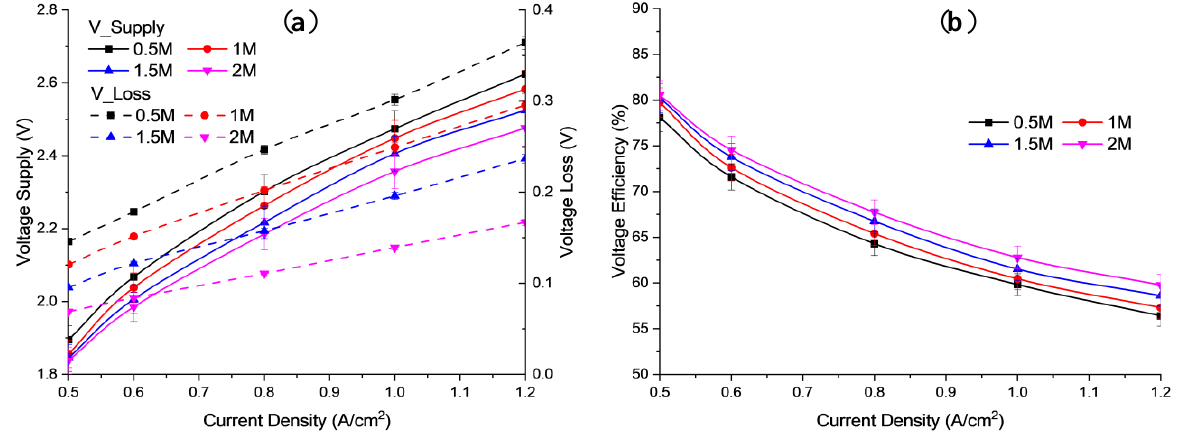
Figure 2. Profile of ( a ) Polarization curve; ( b ) Voltage efficiency, for different alkaline concentrations at 6 mL/min flow rate and 30 °C operating temperature.